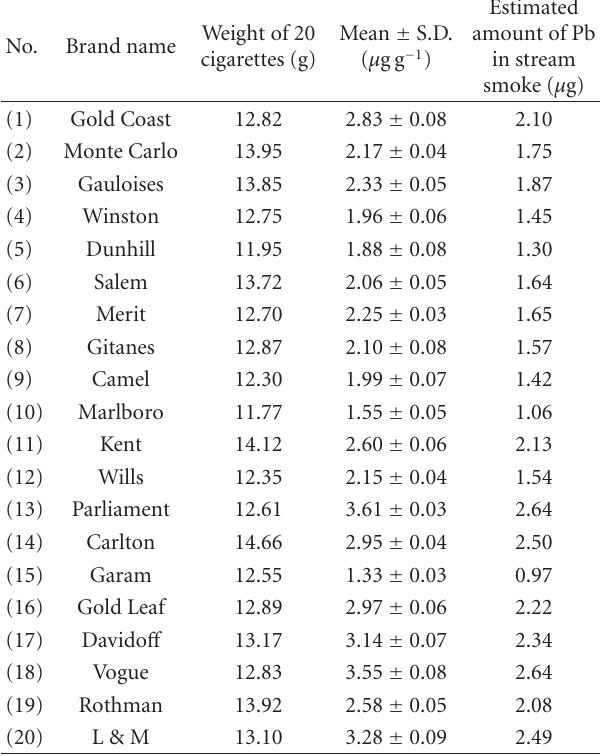
Table 1: Results obtained for the standard reference materials together with certified value.